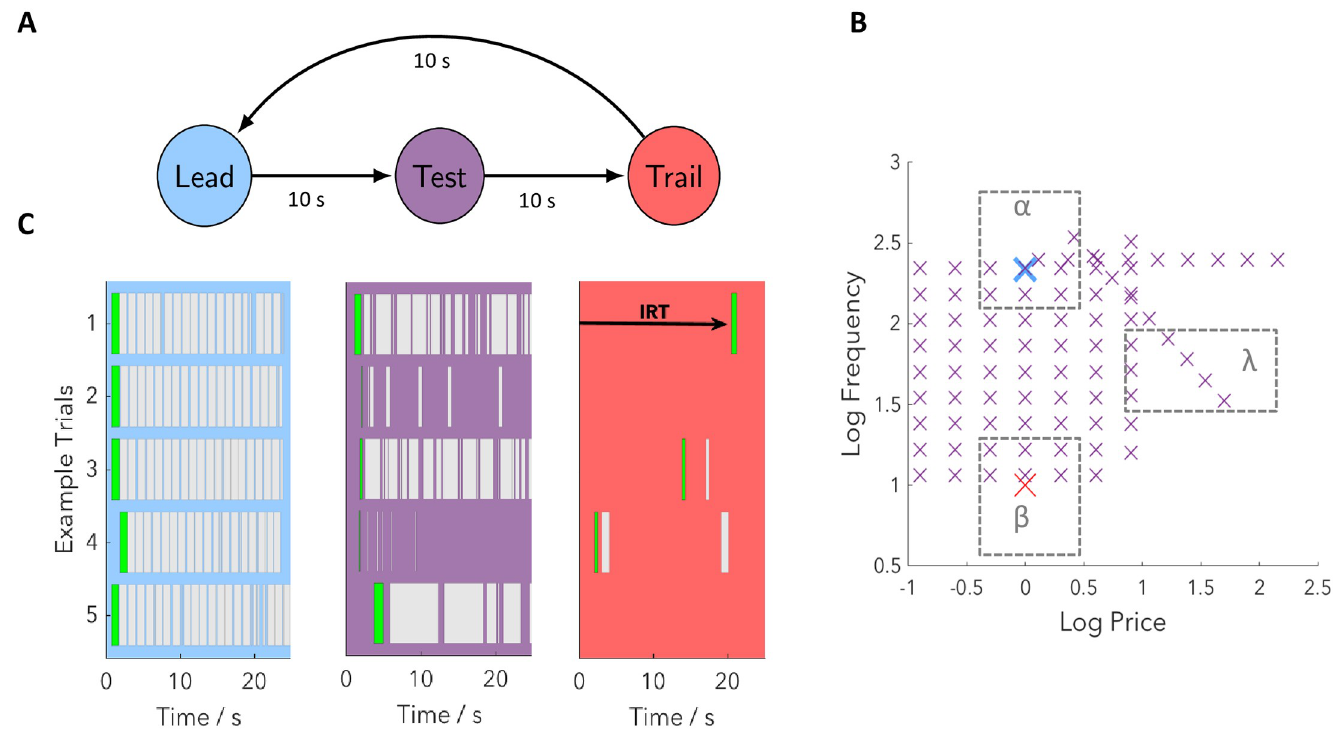
Fig 1. The structure of the experiment. ( A ) Trials come in a predictable cyclic triad. Each trial corresponds to a period of time where price and frequency are fixed. The intertrial interval is 10s. ( B ) Frequencies and prices associated with each trial type (subject 1). Lead trials are highly rewarding with a fixed high pulse frequency and a short price (blue cross). Trail trials are negligibly rewarding with a fixed low pulse frequency and a short price (red cross). Test trails vary in frequency and price from trial to trial and so are variably rewarding (purple crosses). In addition to the crosses we also define regions α , β and λ (dashed grey rectangles) which are relevant for Fig 3. Note that in regions α and β , test trials are similar to lead and trail trials respectively, whereas in region λ test trials are dissimilar to both. ( C ) Responses from five example triads of trials from a trained subject (subject 1). Grey bars correspond to the lever being depressed, with initial responses highlighted in green. Pressing is almost continuous on lead trials, varies on test trials from trial to trial (only the first 25s is shown) and is rare on trail trials. We label the IRT, which reflects subjects’ beliefs about the rewarding nature of the current trial before they have experienced any within-trial evidence.